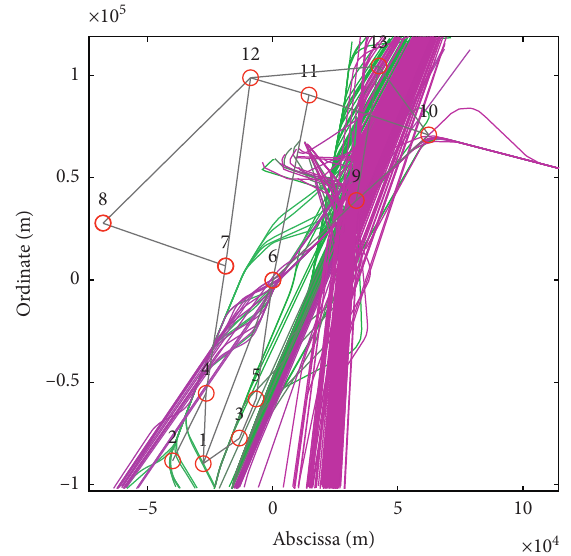
Figure 6: Traffic flow through P449 extracted on December 14, algorithm [21], the FNN method (false proximity